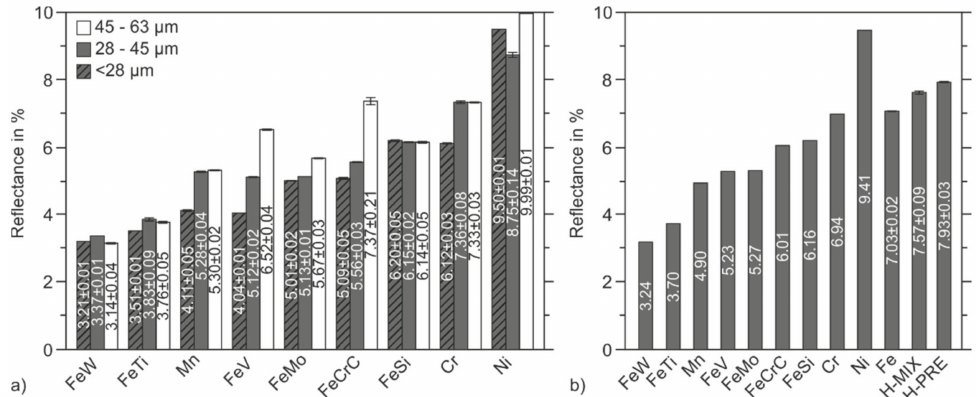
Figure 7. Reflectance of different materials ( a ) elemental powders and ( b ) average reflectance of the three fractions of elemental powders and ferroalloys and reflectance of Fe, H-MIX, and H-PRE in the fractions 20–63 µ